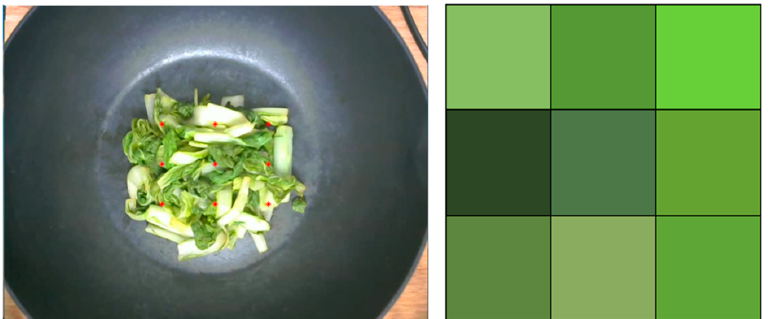
Figure 9. HSV components after lettuce is cooked. Left: nine sampling points. Right: the color of nine sampling points.